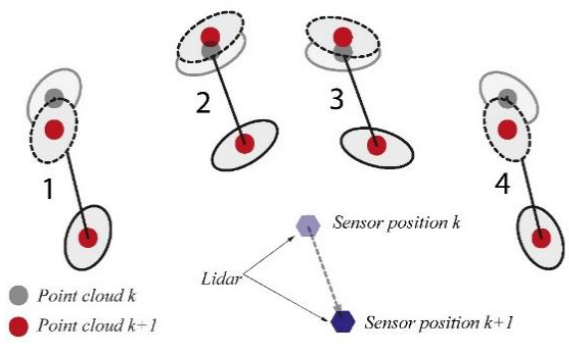
Figure 7. A graphic presentation of the corrected position of the points matched in pairs using the sums of mean errors calculated along the lines connecting the matched points.